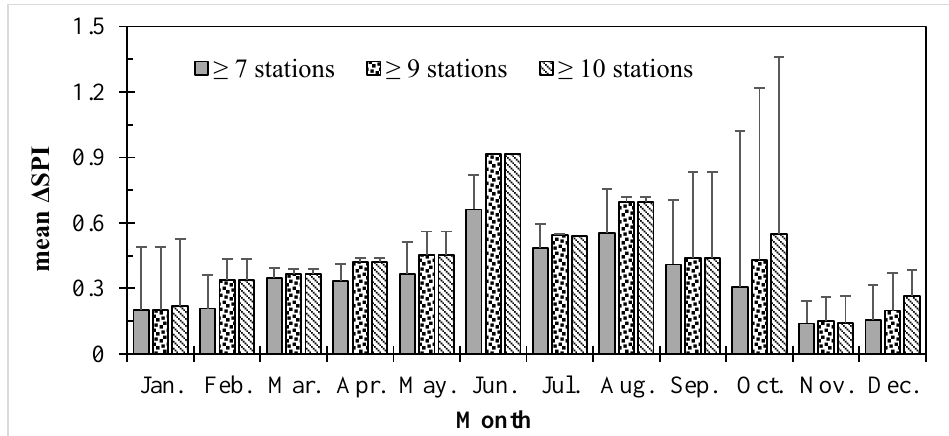
Figure 7. Seasonal variation of ∆ SPI and its change with station number for monitoring regional droughts in the same period.